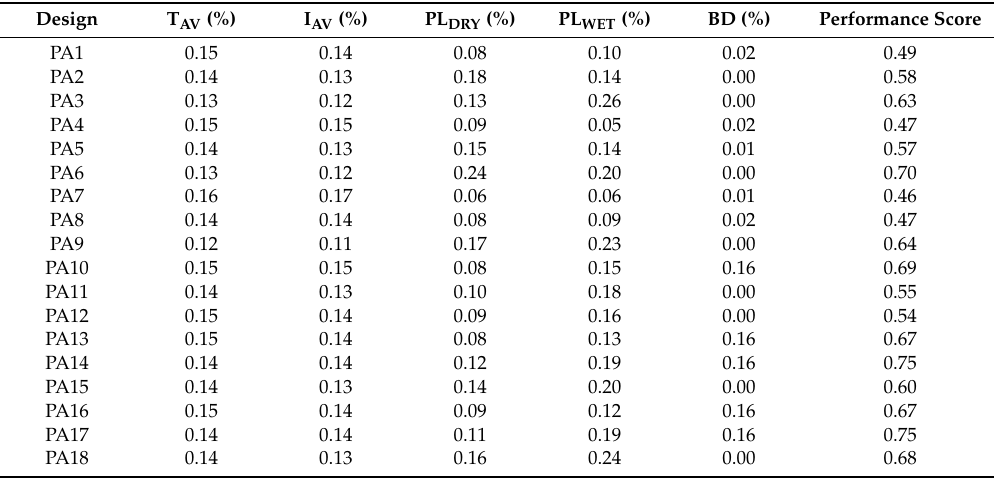
Table 11. Weighted normalized sum